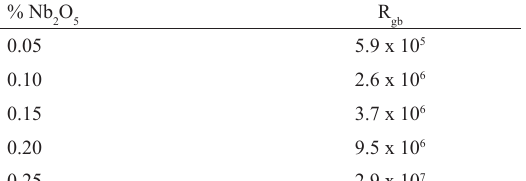
Table 3. Grain boundary resistance through simulations by Equivcrt program for each studied composition.